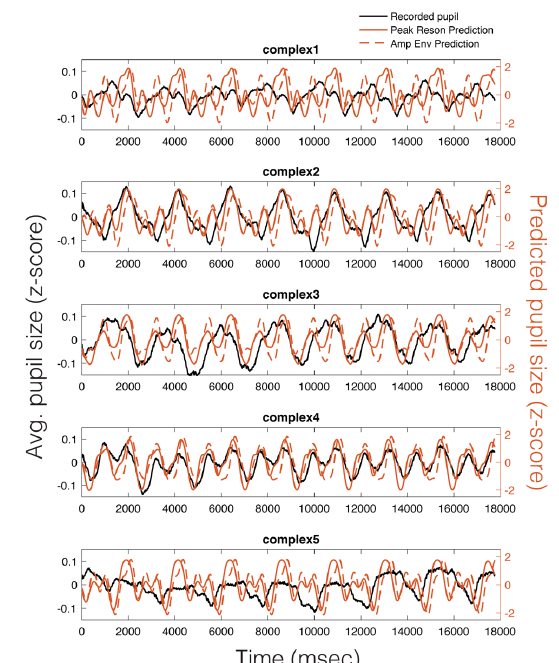
Figure 6. Average pupillary power spectral density (PSD) across participants (black) vs. peak reson filter model-predicted PSD for each stimulus (solid red) and am- plitude envelope-predicted PSD (dashed